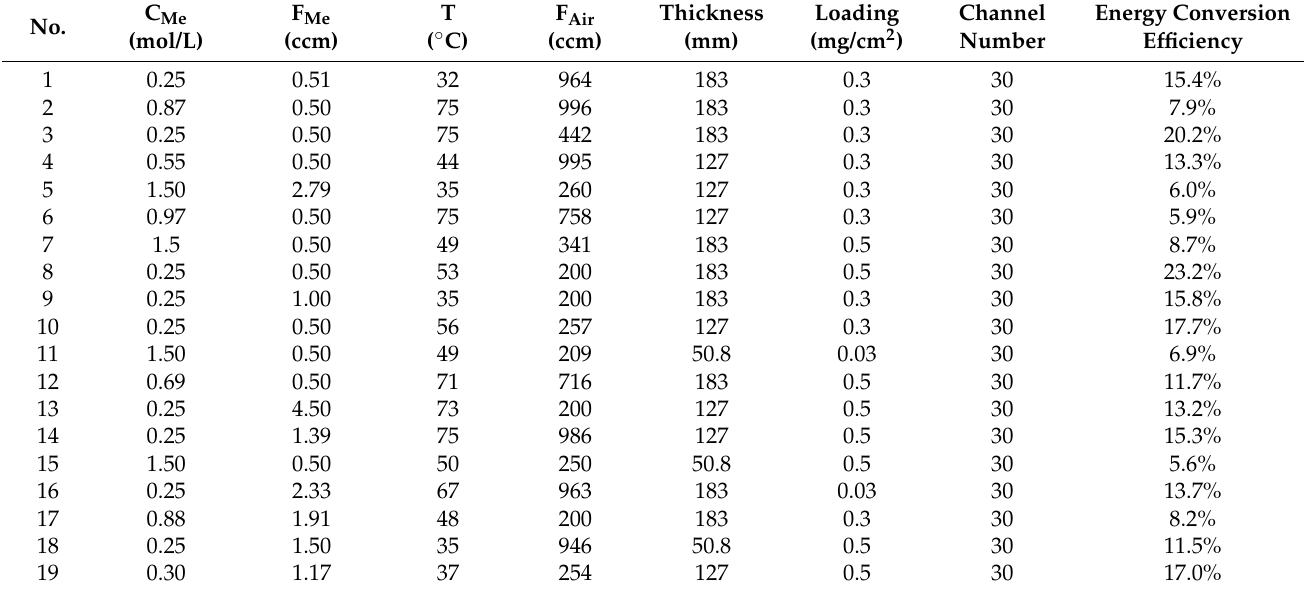
Table 4. Adaptive sampling